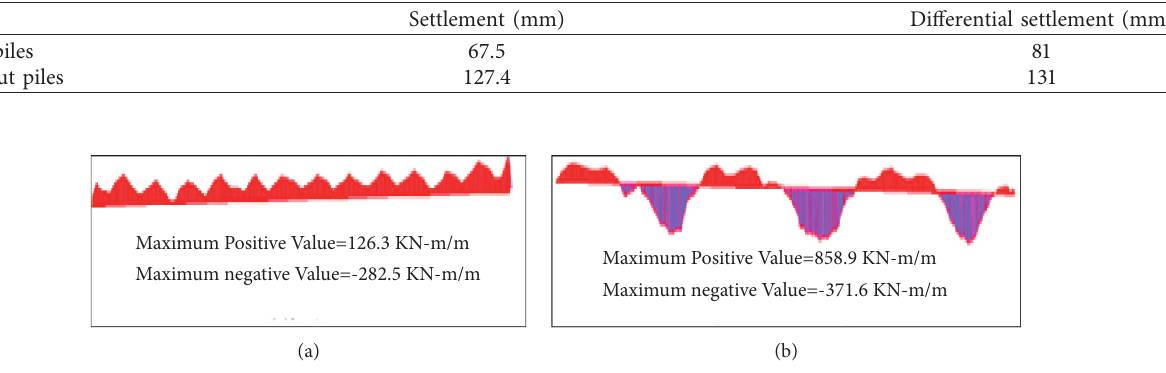
Table 6: Analysis results of raft settlement with and without piles.